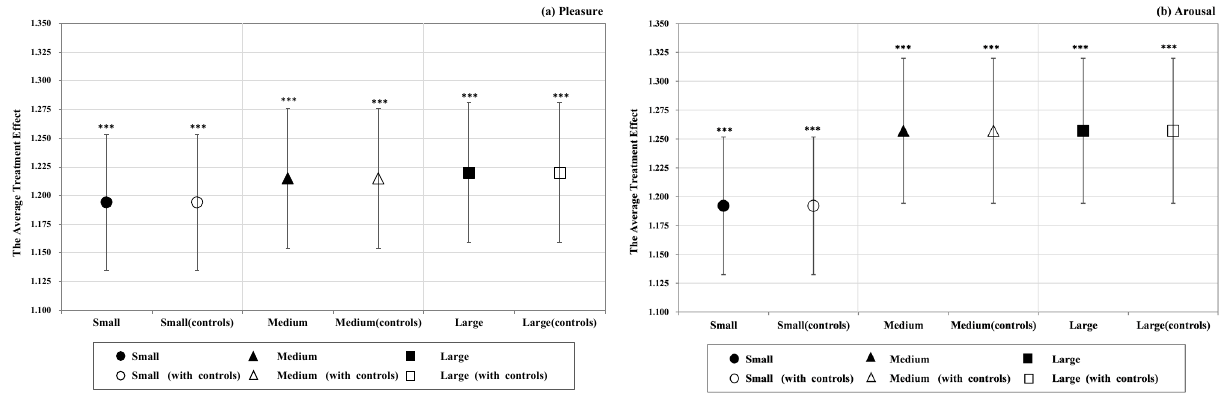
Figure 4. The effect of three scale intervention on tourists’ momentary emotional experience; ( a ) pleasure, ( b ) arousal. Note: Error bars represent 95% confidence interval. *** p < 0.001.